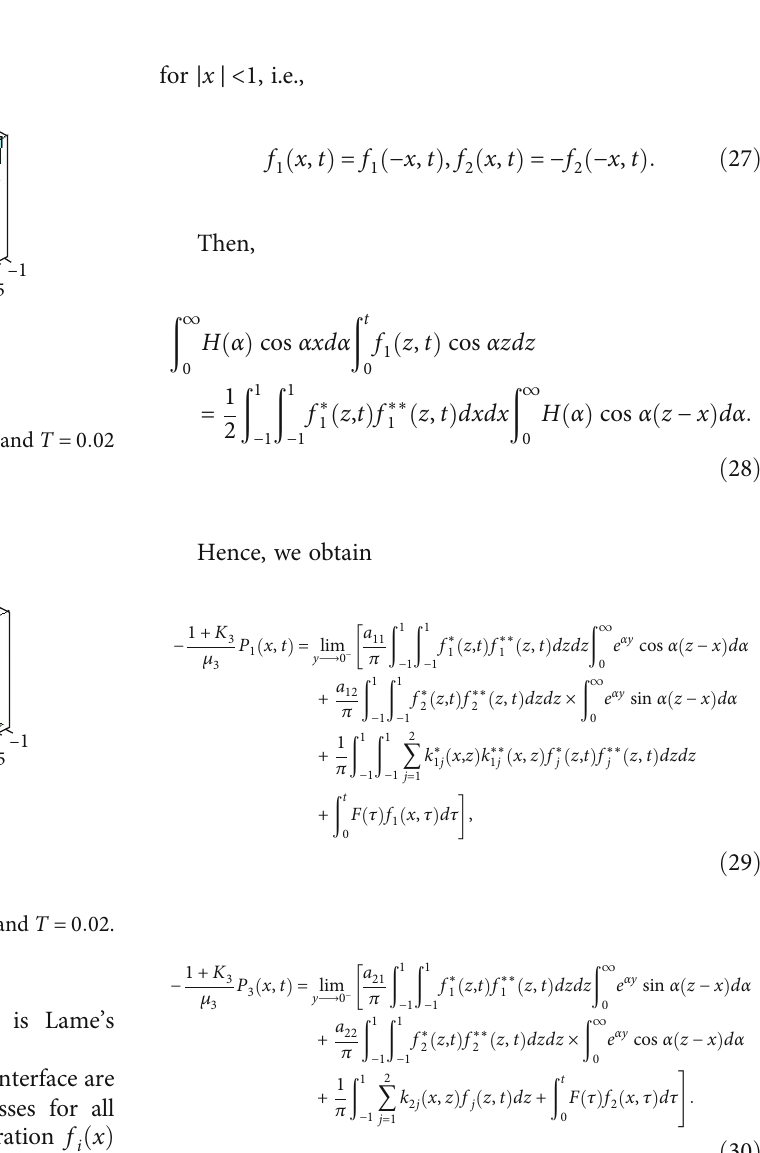
Figure 3: The value absolute error by PNM at N = 10 and T = 0 : 02 .